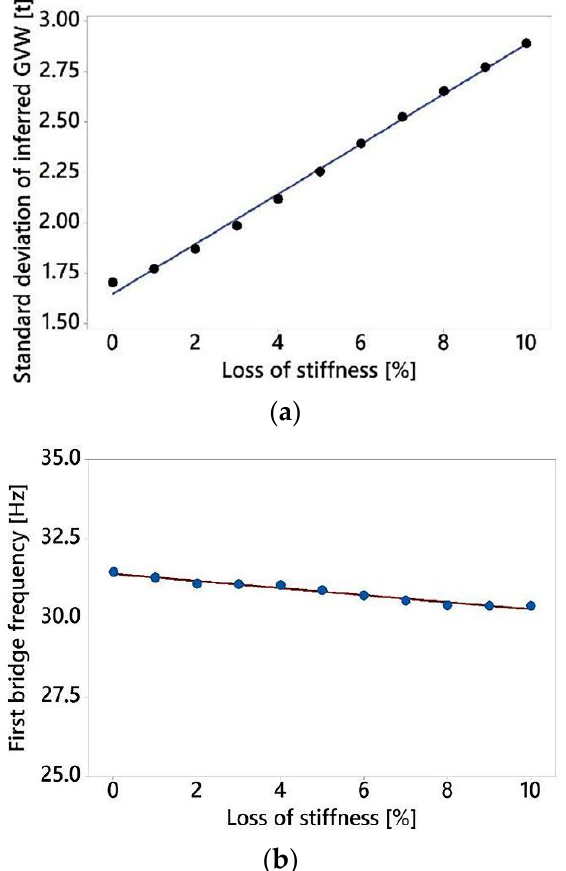
Figure 10. Change in damage indicators with the percentage loss of bridge stiffness: ( a ) standard deviation of inferred GVWs; ( b ) mean 1st bridge natural frequency.